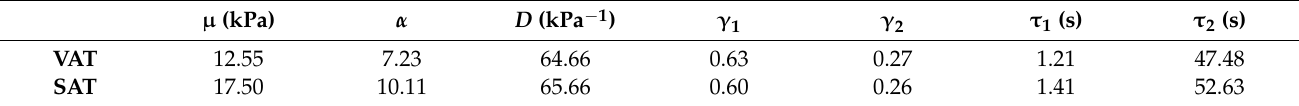
Table 3. Visco-hyperelastic constitutive parameters for VAT and SAT.